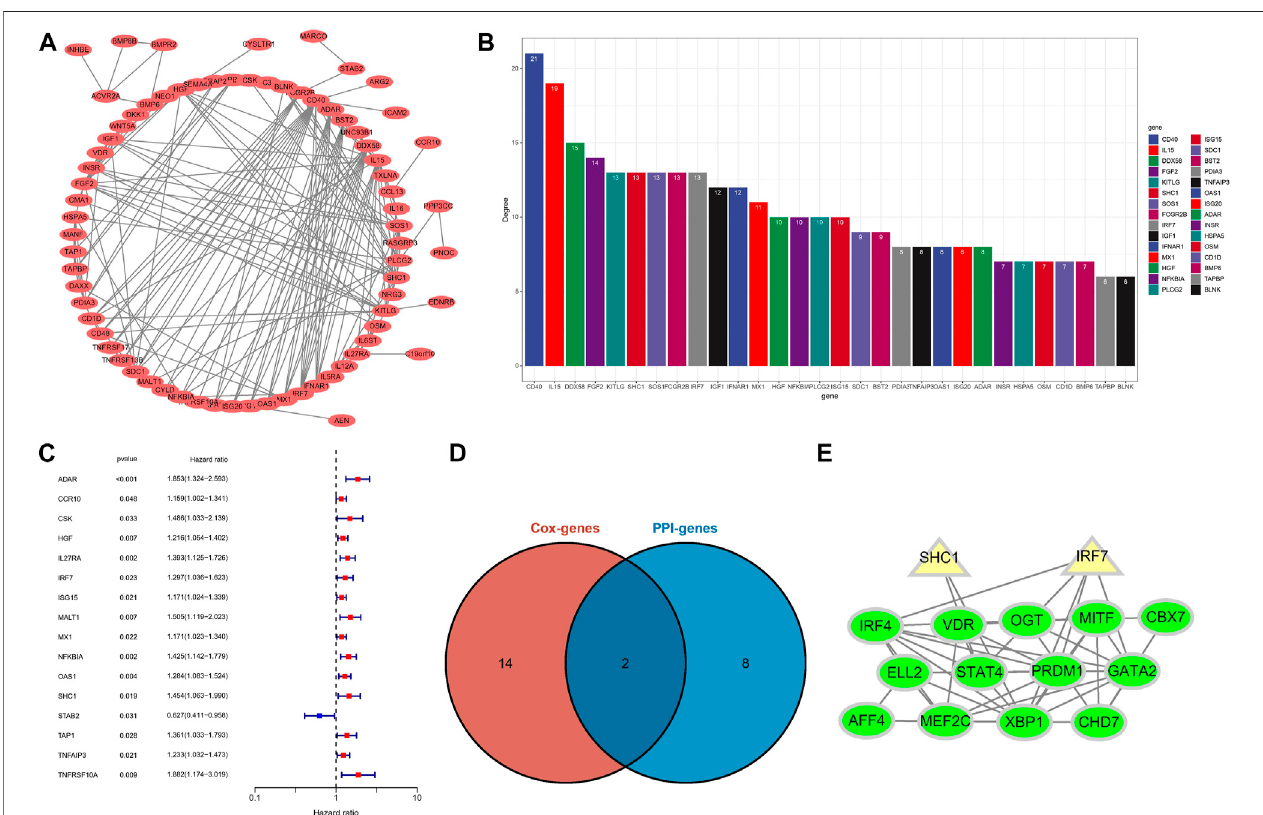
FIGURE8| Identi fi cationofhubIRGsrelatedtoprognosisinPPInetwork. (A) BasedontheSTRINGdatabase,88IRGsringPPInetworksareconstructed. (B) PPI network analyzes topological degree. (C) A forest plot of univariate Cox regression analysis in the entire set. (D) Venn plot of the Top10 IRGs of PPI network and prognostic-related IRGs. (E) Analysis of the interaction between TFs and core IRGs.